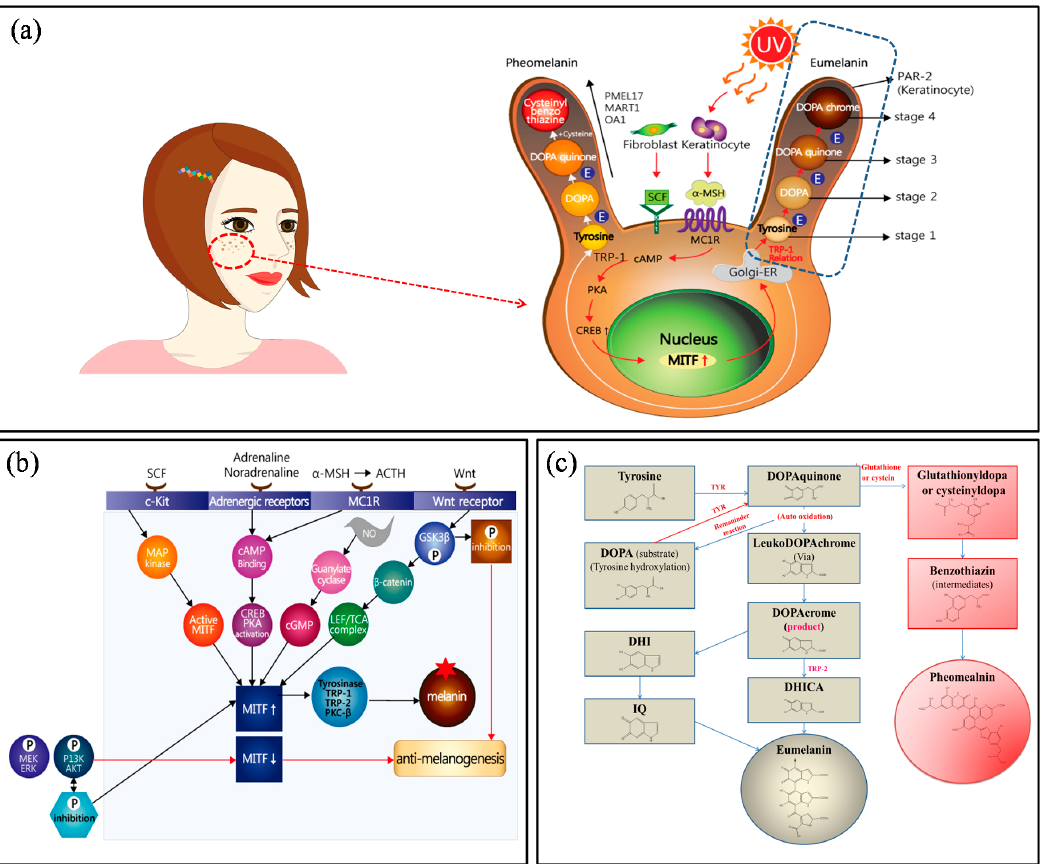
Figure 1. ( a ) Schematic representation of melanosome and melanin formation mechanism; ( b )